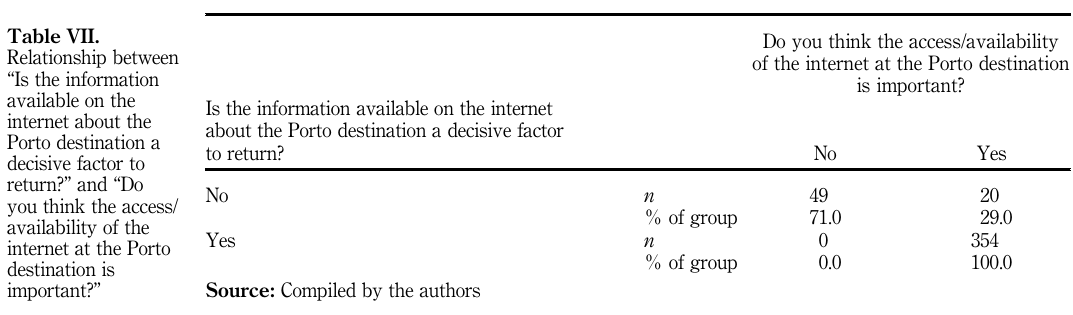
“ Was the information available on the internet about the Porto destination a decisive factor to come? ” and “ Do you access the internet from mobile/computer devices? ”